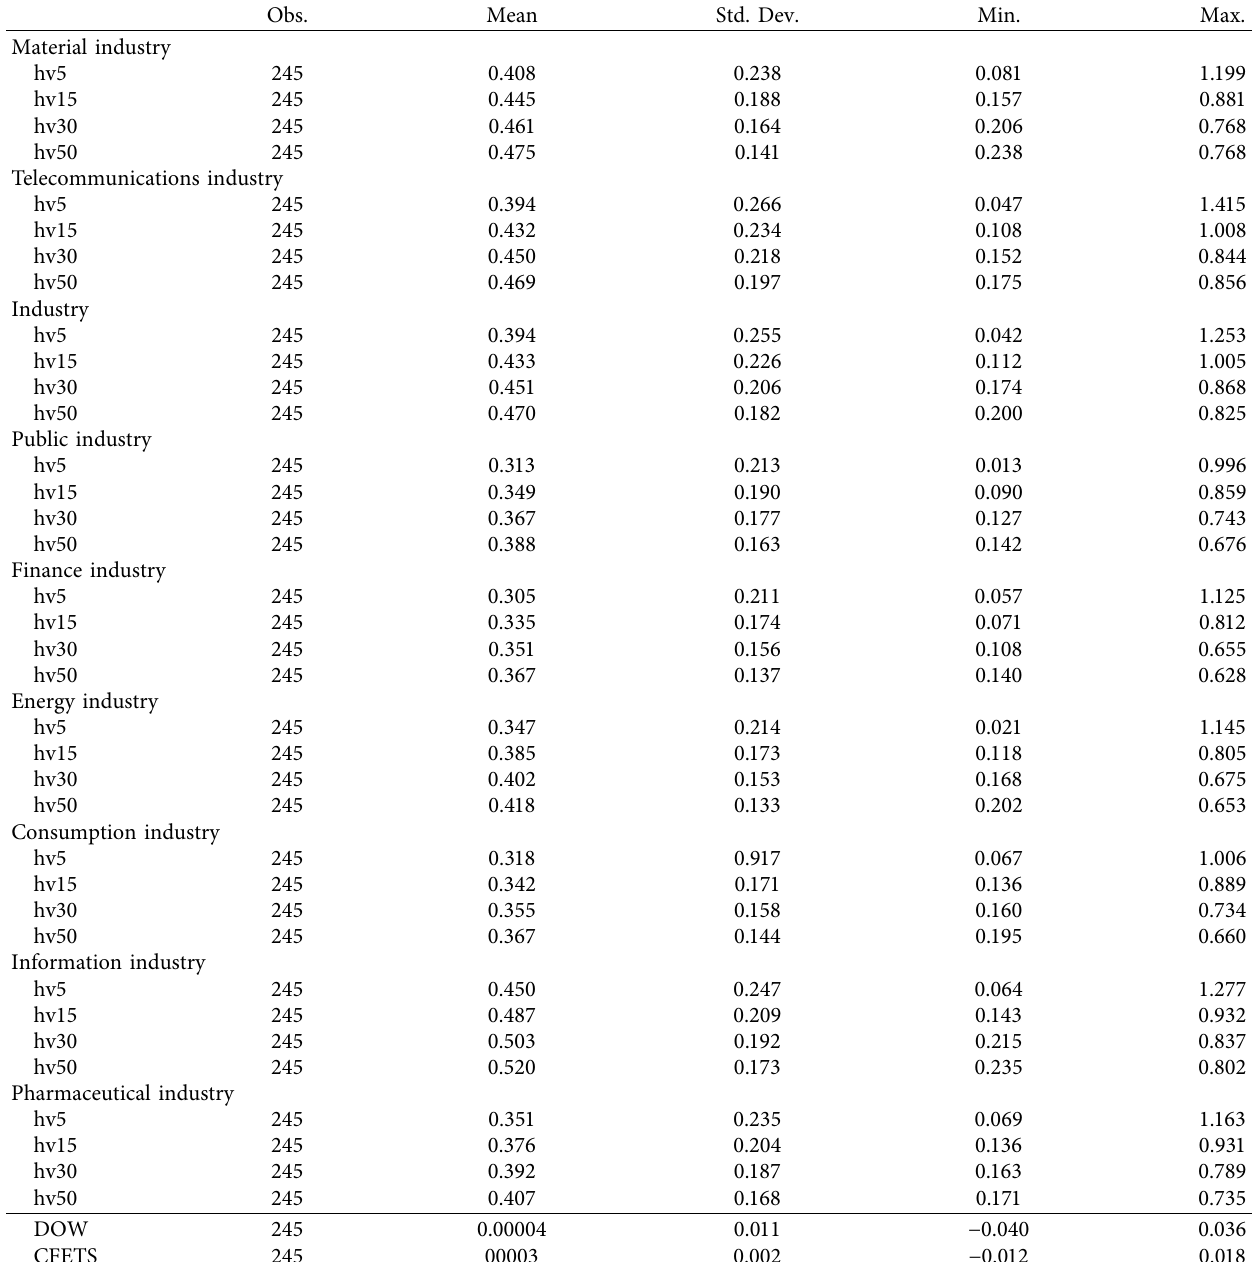
Table 1: The basic description of the